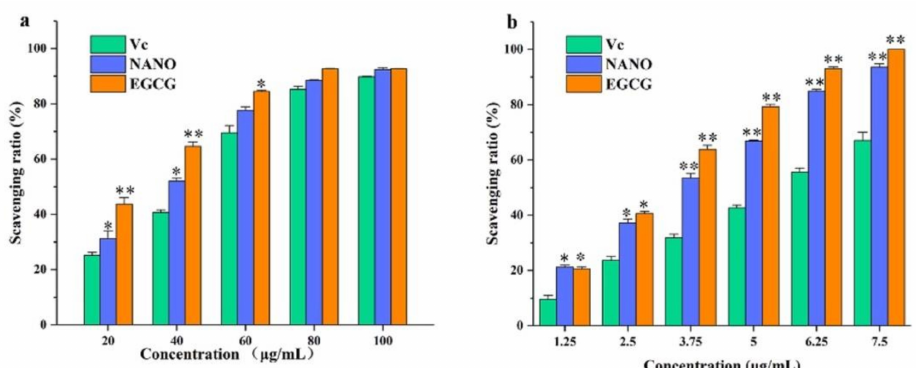
Figure 2. ( a ) DPPH and ( b ) ABTS radical scavenging activities of vitamin C, NANO, and EGCG at different concentrations. The “*”, and “**” represent p < 0.05, and p < 0.01. Reprinted and adapted with permission from [25]. Copyright 2021 American Chemical Society.